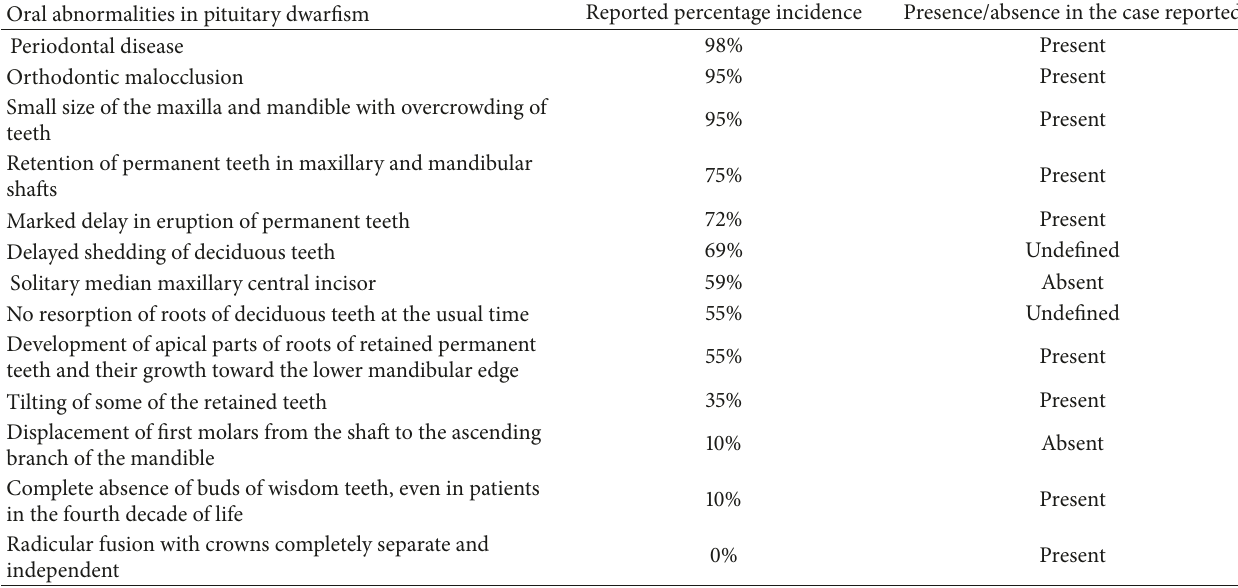
Table 1: Incidence of dental anomalies in pituitary dwarfism resulting from a search of PubMed for “oral cavity hypopituitarism” (ordered from most to least frequent